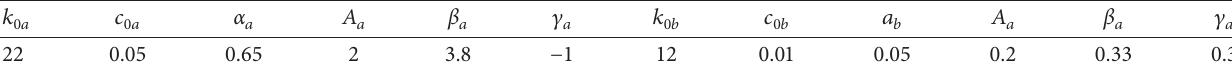
Figure 2: Flowchart of parameter identification using numerical optimization algorithm. Table 1: Parameter values of MRE-based absorber using the Bouc–Wen